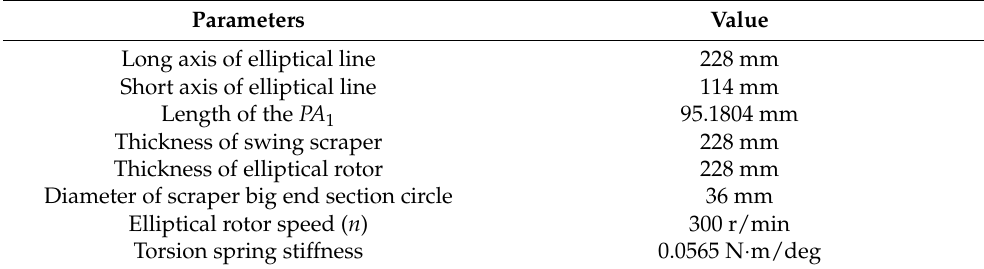
Table 1. Basic parameters of the ERSP. Parameters Value Long axis of elliptical line Short axis of elliptical